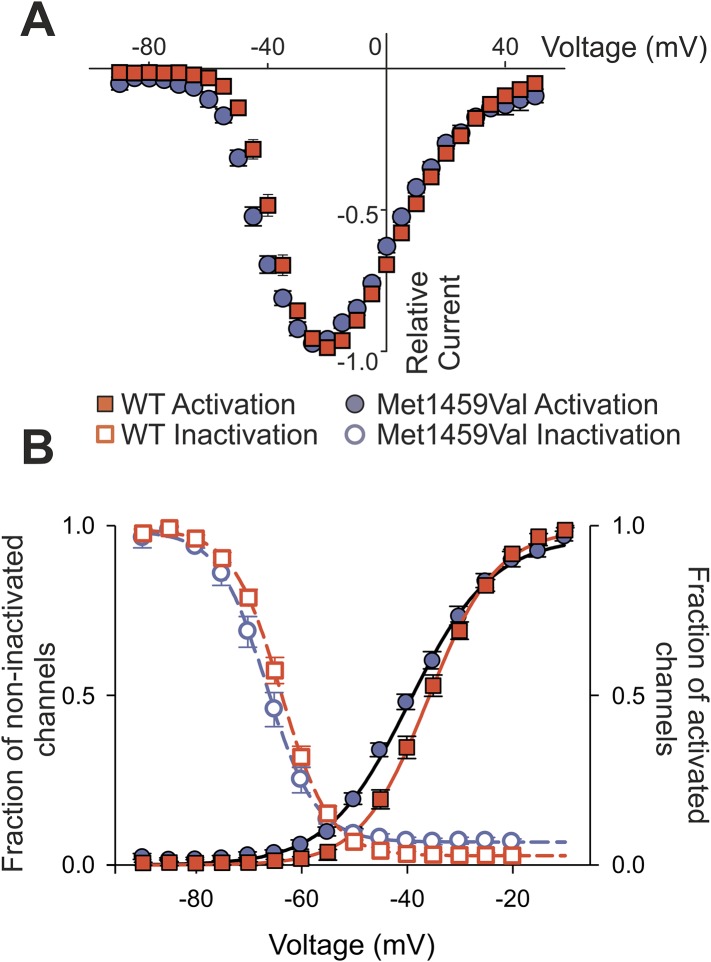
CACNA1HM1549V shifts activation to more hyperpolarized potentials.(A) Current-voltage plots and (B) activation curves show a shift of V1/2 for activation of the mutant channel to less depolarizing potentials. The voltage dependence of inactivation is shown as open circles or squares. For CACNA1HM1549V, the area under the intersection of activation and inactivation curves (where a fraction of channels show continuous activity) is larger and shifted to more hyperpolarized potentials compared to CACNA1HWT, allowing for increased constitutive Ca2+ influx at potentials close to the resting potential of zona glomerulosa cells (Hu et al., 2012). Source files are available in Figure 6—source data 1.DOI:
http://dx.doi.org/10.7554/eLife.06315.01410.7554/eLife.06315.015Figure 6—source data 1.Source data corresponding to Figure 6.